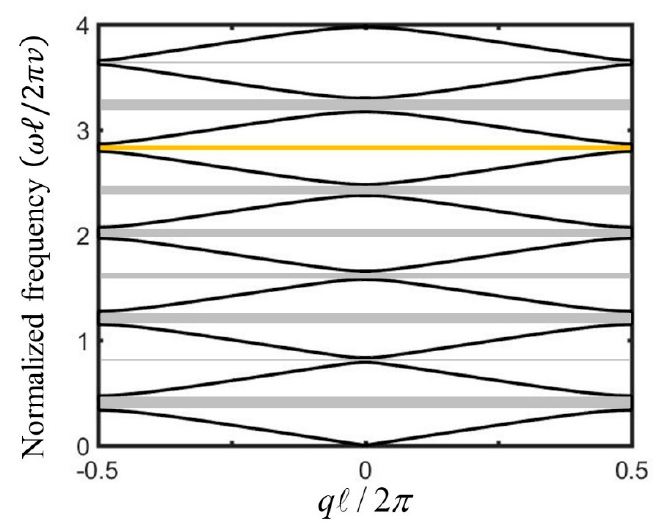
Figure 2. The band structure (solid black curves) with the parameters ρ A = 2704 kg/m 3 , ρ B = 8100 kg/m 3 , ℓ A = 0.6759 ℓ and ℓ B = 0.3241 ℓ . Grey and orange strips represent the band gaps. The topological properties of the orange strip are considered in our main text.